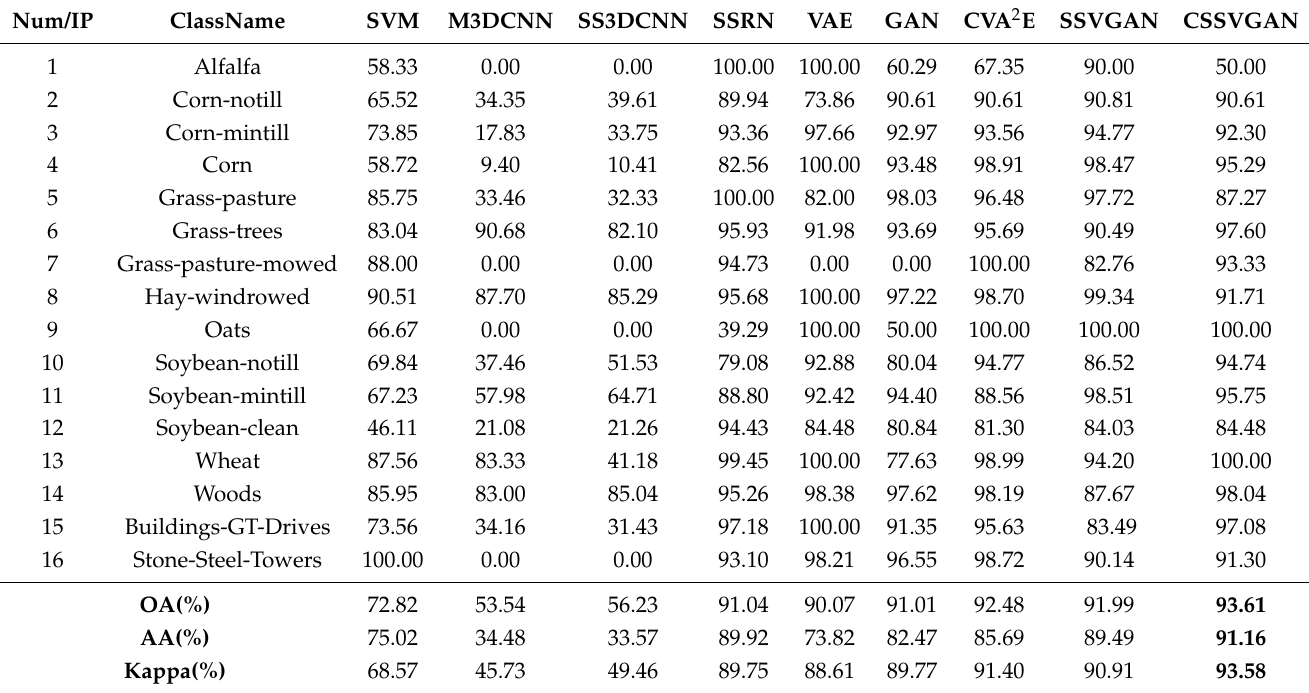
Table 9. The classification results for the IP dataset with 5% training